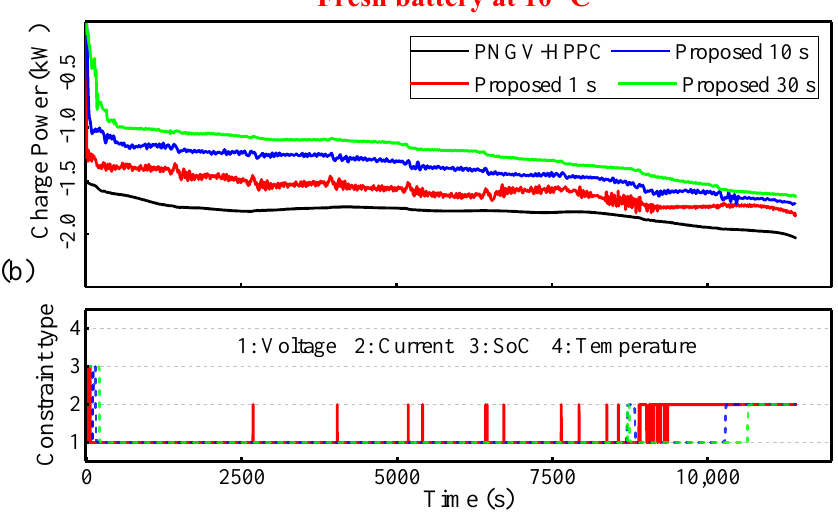
Figure 4. SoP prediction results with the active constraint on fresh B2 at 10 °C: ( a ) discharge power; ( b ) charge power.